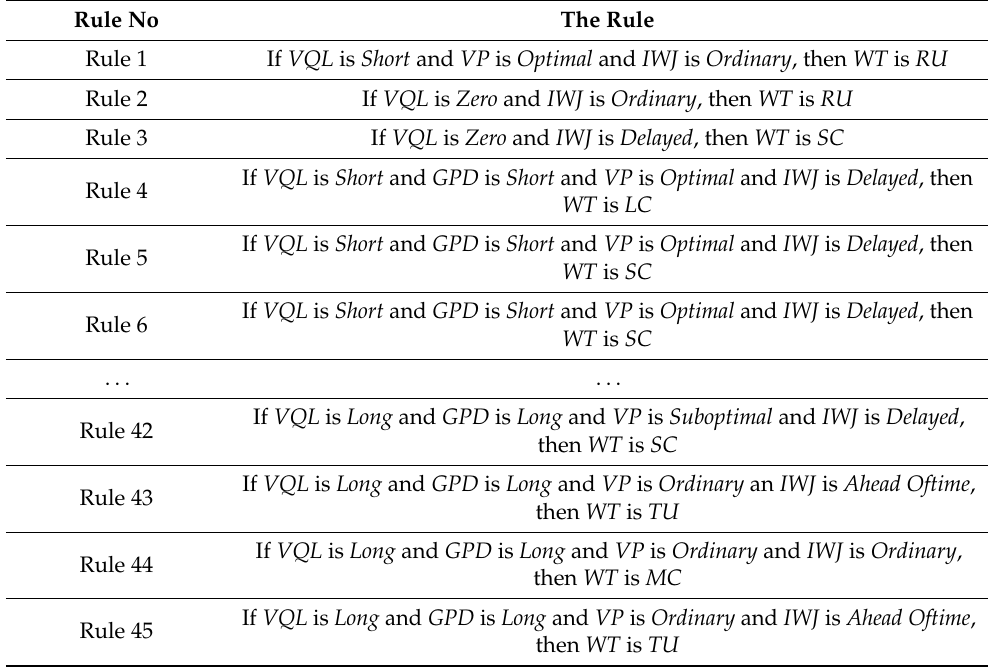
Table 1. Some rules example of the fuzzy